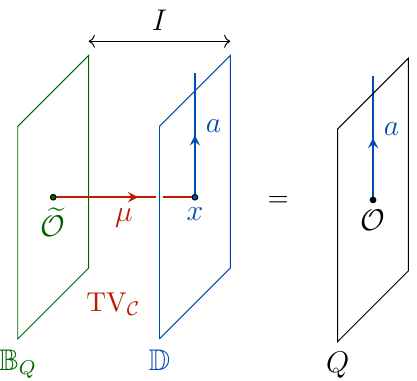
Figure 3 . A defect operator O ∈ H a of the 2d theory Q is composed of a bulk anyon µ ∈ Z ( C ) and a pair of boundary (defect) operators. Via the state-operator correspondence, e O belongs to the µ -punctured disk Hilbert space of TV C with boundary condition B Q , and x belongs to Hom C ( F ( µ ) , a ) where F : Z ( C ) → C describes the fusion of bulk anyons with the topological boundary D